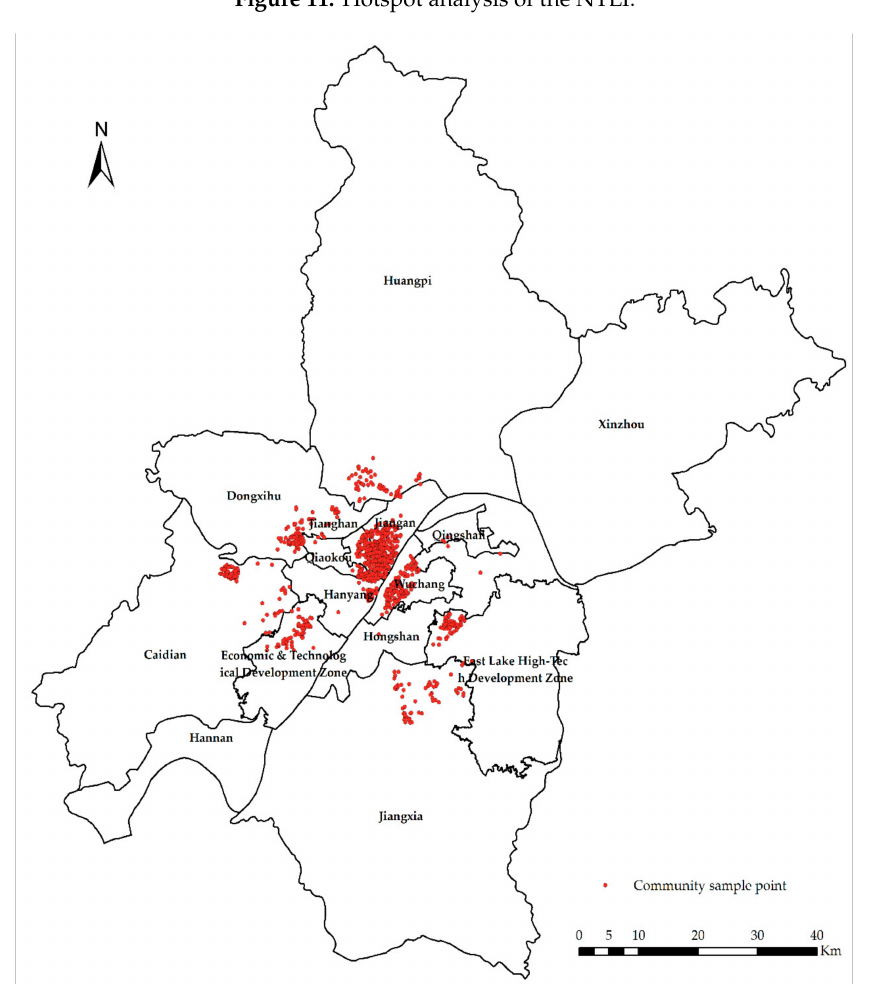
Figure 12. Results of the overlay